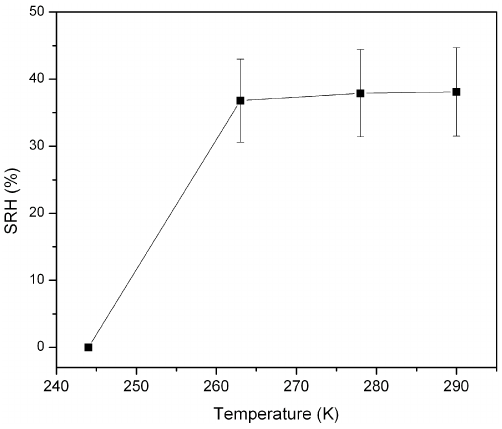
Figure 6. SRH as a function of temperature for particles contain- ing α ,4-dihydroxy-3-methoxybenzeneacetic acid mixed with am- monium bisulfate. Bars for the data are 95% confidence intervals considering σ of multiple SRH measurements and the uncertainty from the calibration. Data at 290 ± 1K were taken from You et al.